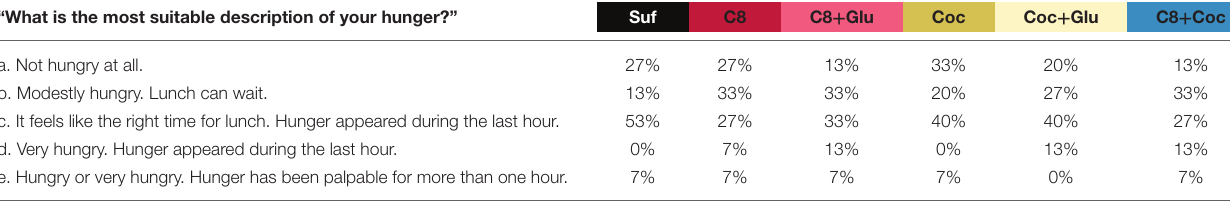
Arm 1: Black was selected to represent the “control” arm. Arm 2 and 4: Red and sand were arbitrarily chosen colors for C8 and Coc. Arm 3 and 5: These arms correspond to 2 and 4, respectively (with glucose added). Colors are therefore the same as 2 and 4, but with lower opacity (in Figures 2 , 5 they are striped, instead of changing opacity). Arm 6: Blue was chosen arbitrarily as a contrasting color.